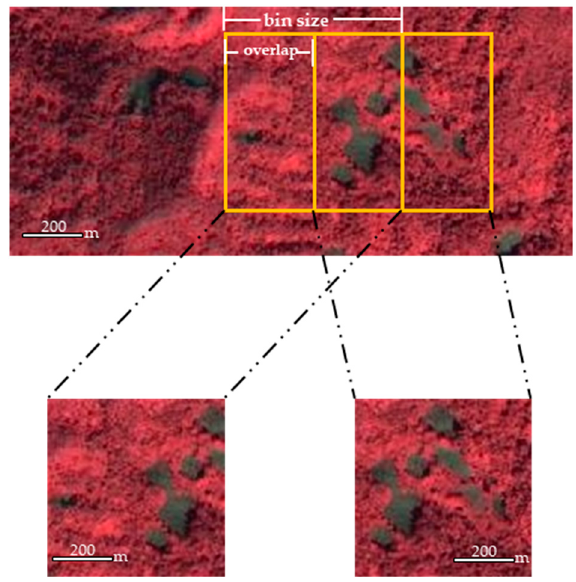
Figure 5. Partitioning of the entire image into smaller fragments via the sliding window. The bin size was set to 300 pixels × 300 pixels, and the overlap was set to 150 pixels.